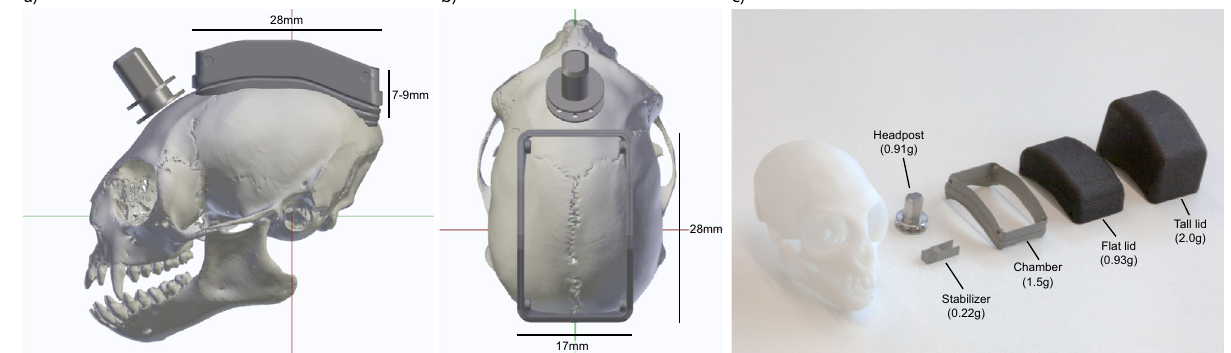
Fig.2|Implantsizeandweight. 3Drenderingofsideview( a )andtopview( b )ofa marmoset skull with headpost and chamber in target position, aligned in stereo- taxic coordinates. Red line indicates interaural axis. Green line indicates